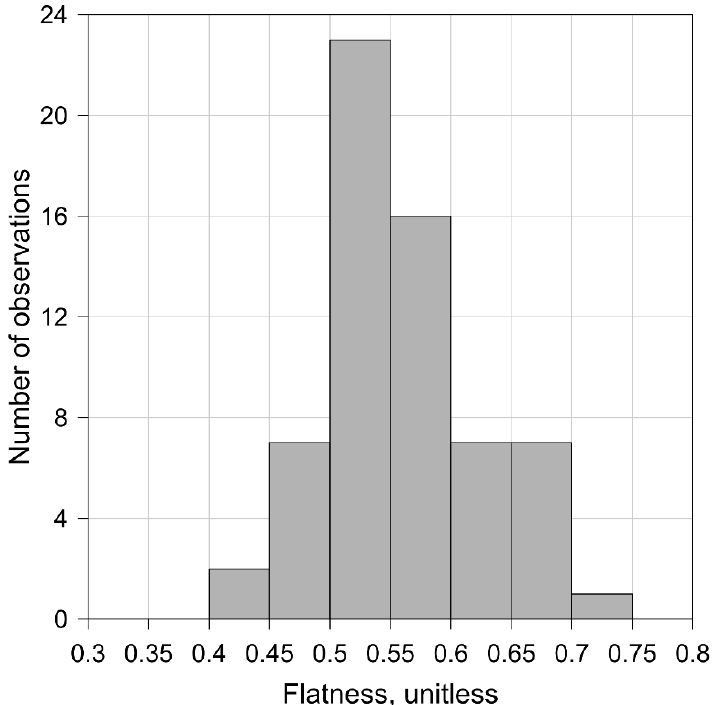
Figure 10. Histogram of object flatness, based on the average values in the samples.